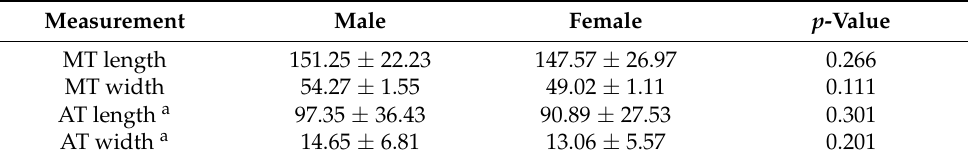
Table 3. Length and width of the extensor hallucis longus (EHL) tendon